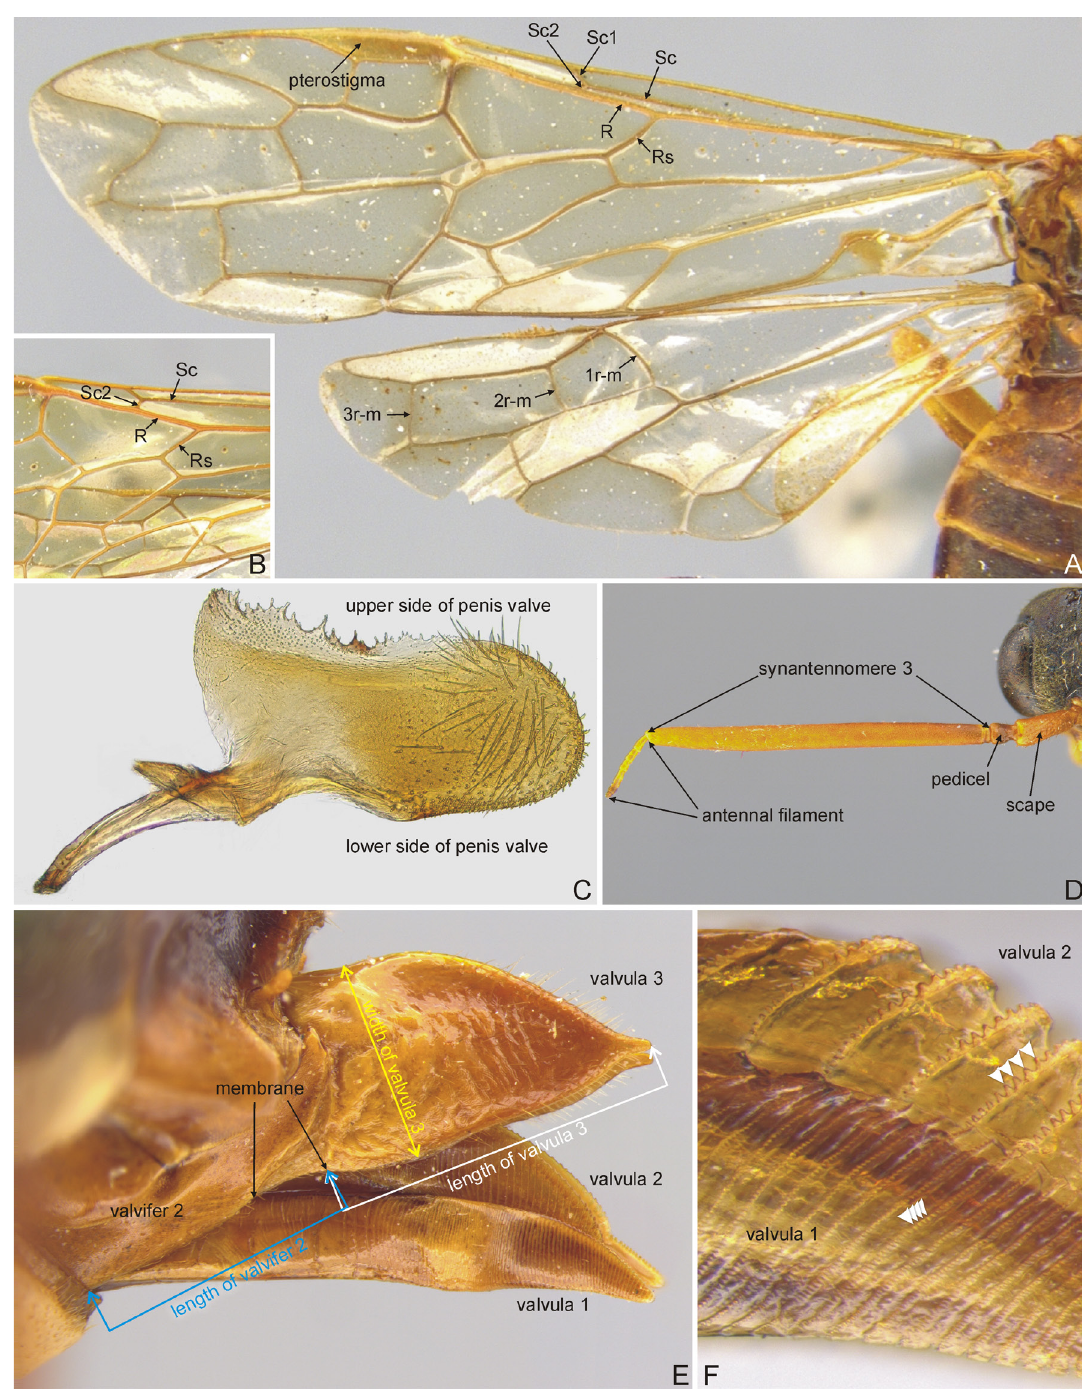
Fig. 1. Megaxyela Ashmead, 1898, morphological terminology. A . M. major (Cresson, 1880) ( ♀, paralectotype, DEI-GISHym 30823, ANSP), wings. B . M. parki Shinohara, 1992 (♀, 18509, NSMT), section of fore wing. C . M. euchroma Blank, Shinohara & Wei sp. nov. ( ♂, paratype, 22513, NSMT), penis valve. D . M. parki (♂, 710, NSMT), antenna. E . M. gigantea Mocsáry, 1909 ( ♀, holotype of M. mikado Sato, 1930, 22350, NSMT), ovipositor and ovipositor sheath, with indication of measurement of length of valvifer 2 (blue), valvula 3 (white), and width of valvula 3 (yellow). F . M. euchroma sp. nov. (♀, paratype, 22558, CSCS), section of ovipositor, white arrow heads indicating teeth of ctenidia on valvulae 1 and